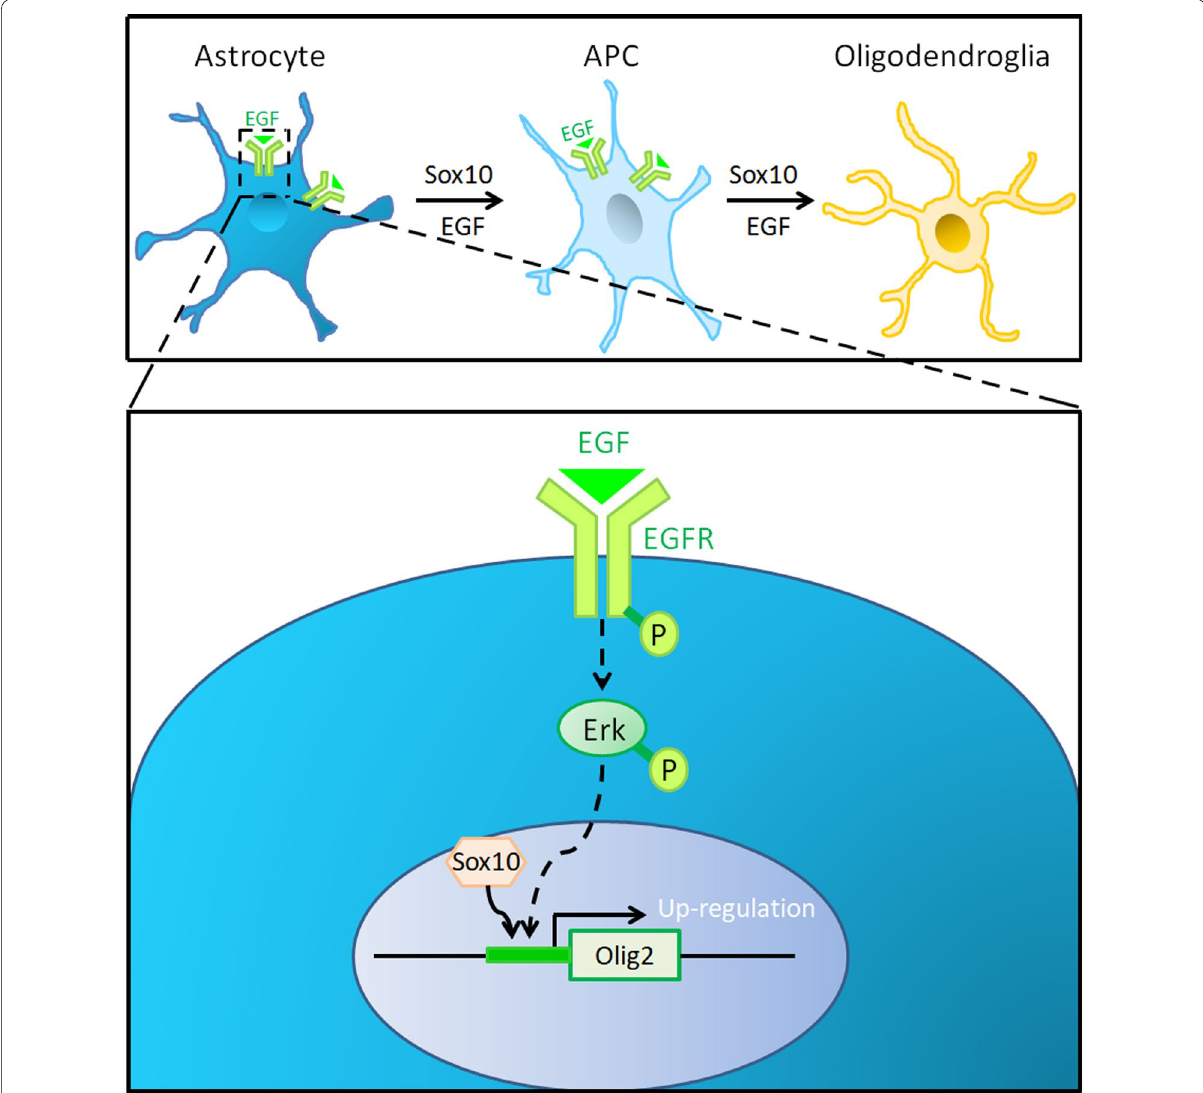
Fig. 6 Proposed model of synergistic induction of transdifferentiation from astrocytes to oligodendrocytes by EGF and Sox10. EGF binds to EGFR to activate the downstream Erk pathway, thereby up-regulating the expression of oligodendrogenic genes, meanwhile, forced expression of Sox10 in astrocytes also promotes Olig2 expression and facilitates astrocyte reprogramming to iOPCs via